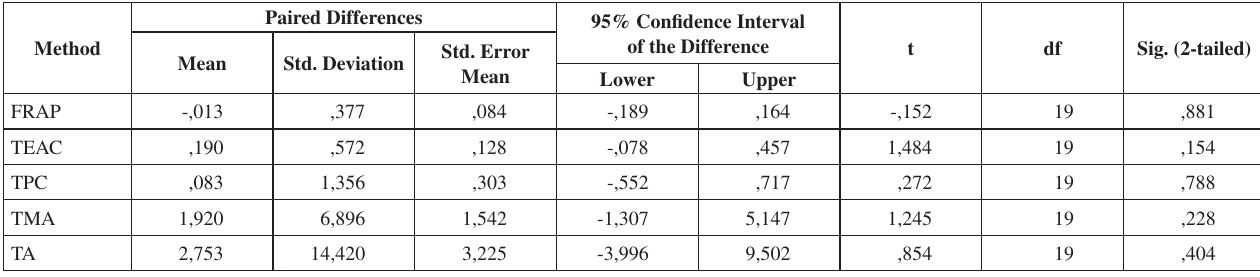
Table 3. Statistical analysis of the results the total antioxidant capacity by FRAP and TEAC, the total polyphenol content by TPC and the total anthocyanin content by TMA and TA